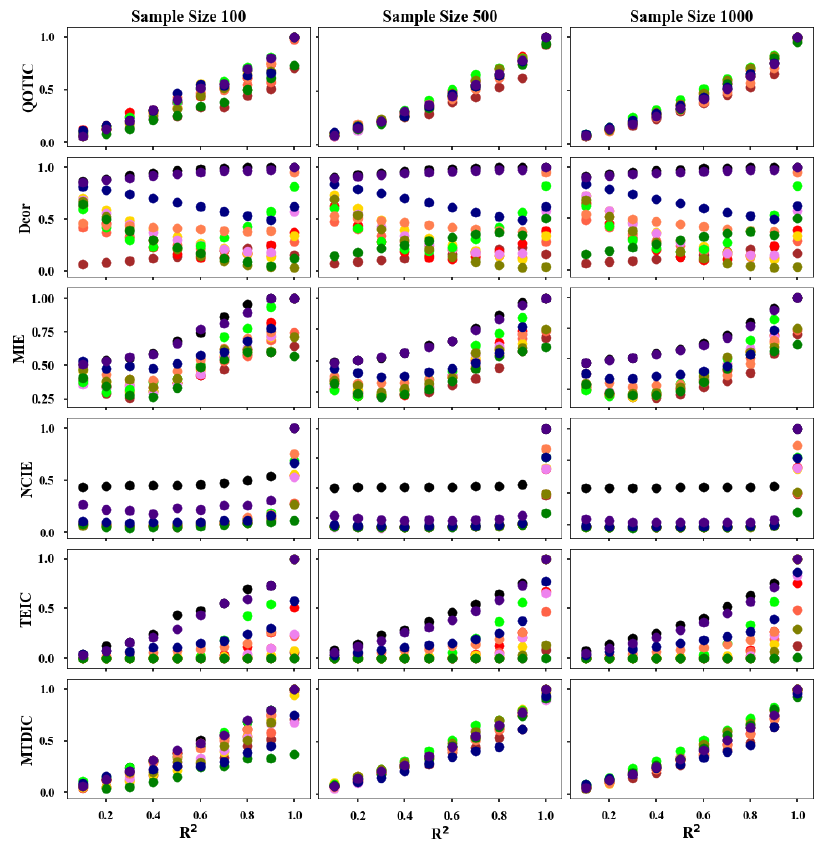
Figure 8. Equitability comparison of six trivariate correlation